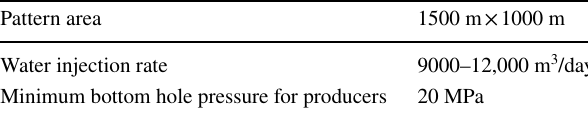
Table 7 Well conditions for the simulation Pattern